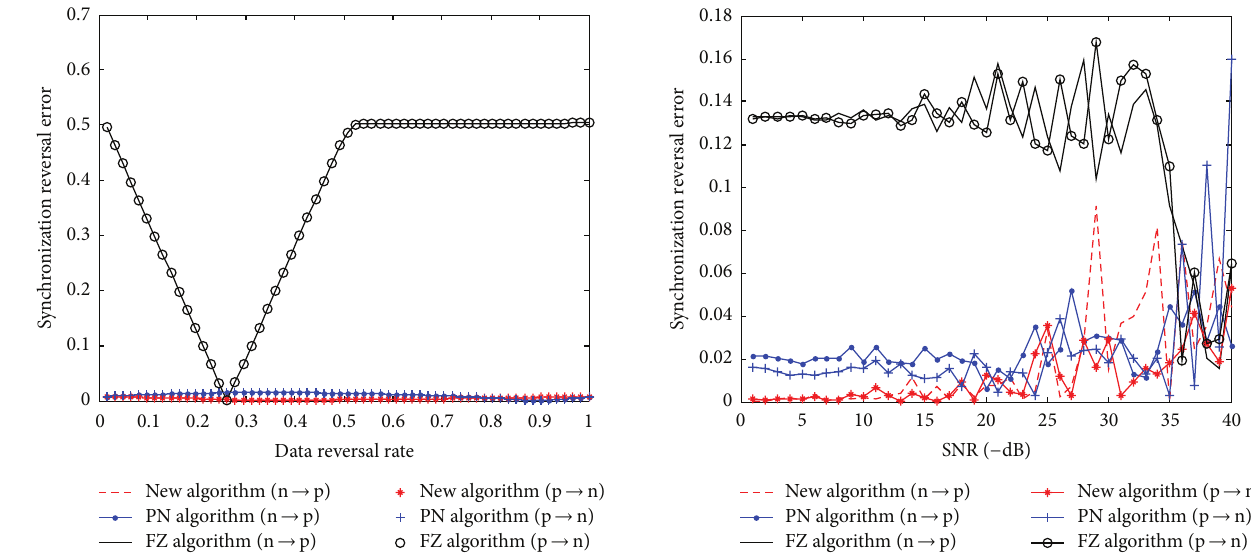
demonstrating that the new algorithm’s synchronization per- formance is the best.